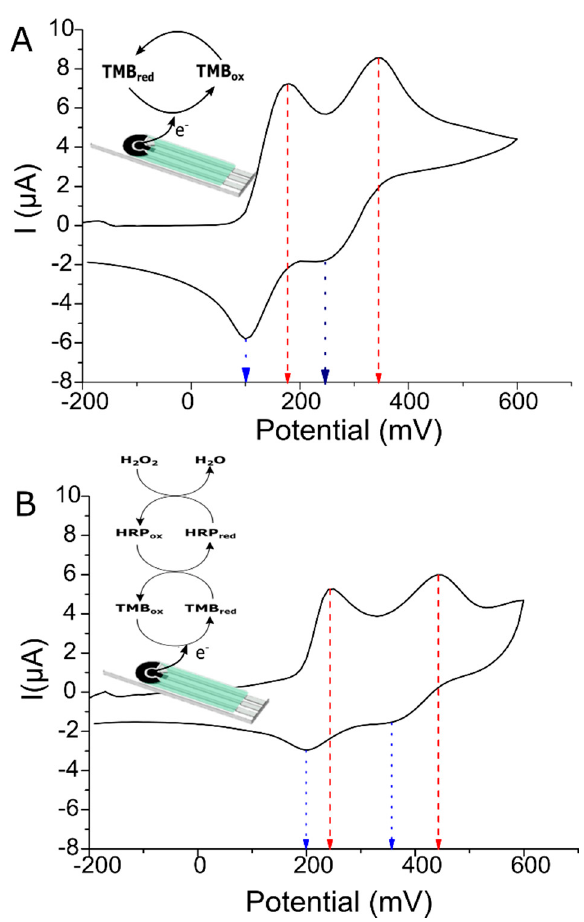
Figure 2. ( A ) Cyclic voltammetry of the substrate 3,3 ′ ,5,5 ′ -Tetramethylbenzidine (TMB) in a screen-printed electrode (SPE). ( B ) Cyclic voltammetry of the substrate 3,3 ′ ,5,5 ′ -Tetramethylbenzidine (TMB) and horseradish peroxidase (HRP) reaction. Peak potentials are highlighted in red (oxidation) and blue (reduction).